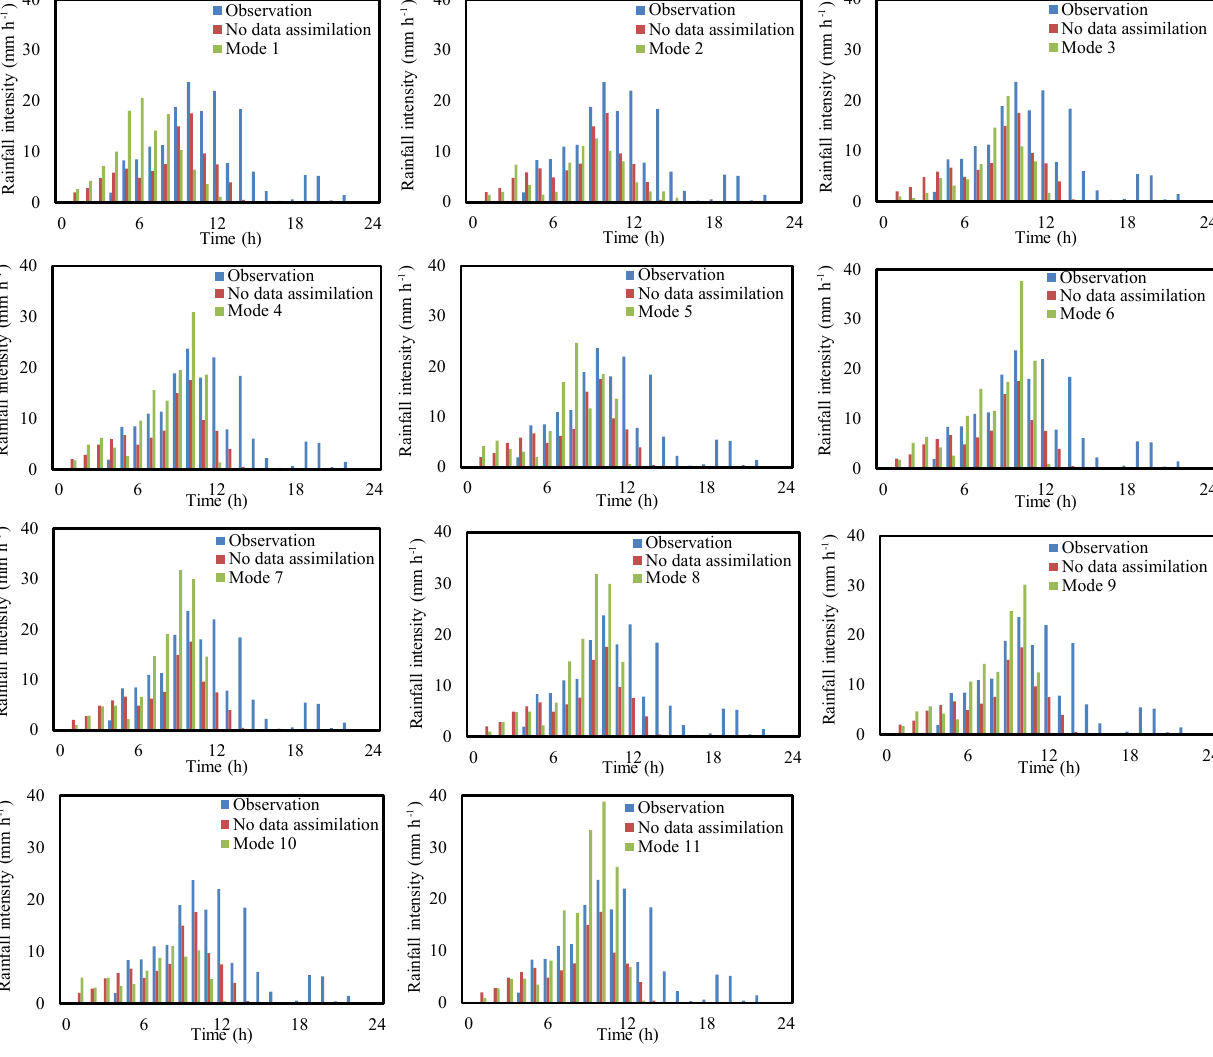
Figure 7. Hyetographs of the observed and forecasted rainfall from different data assimilation